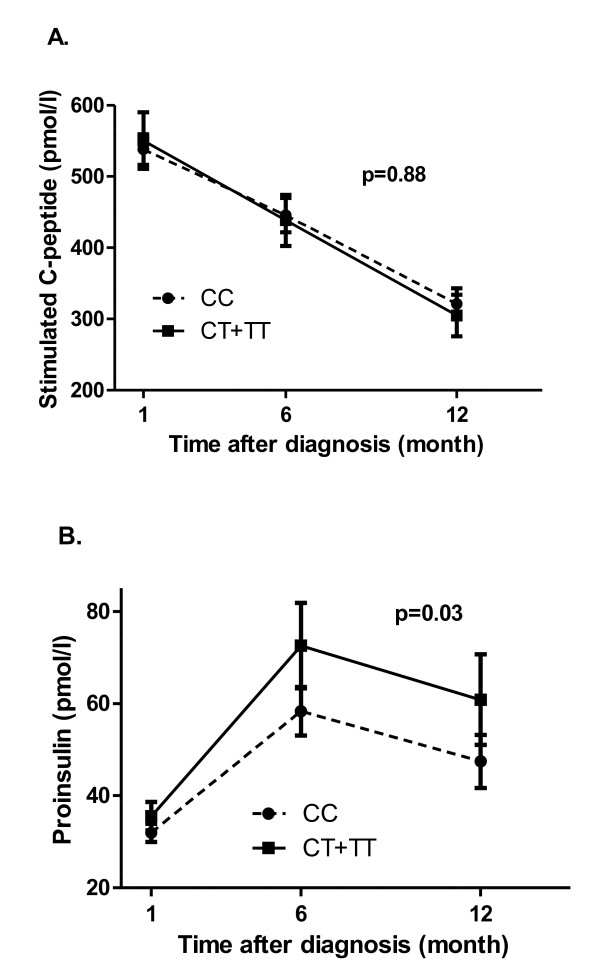
Stimulated C-peptide and proinsulin over time according to PTPN22 genotypes. The association of stimulated C-peptide (A.) and proinsulin (B.) level 1, 6 and 12 months after disease onset by PTPN22 genotype (homozygous+heterozygous (CT+TT) (n = 71) carriers of the variant versus wildtype (CC) (n = 186)). Mean values (pmol/l) ± SEM.